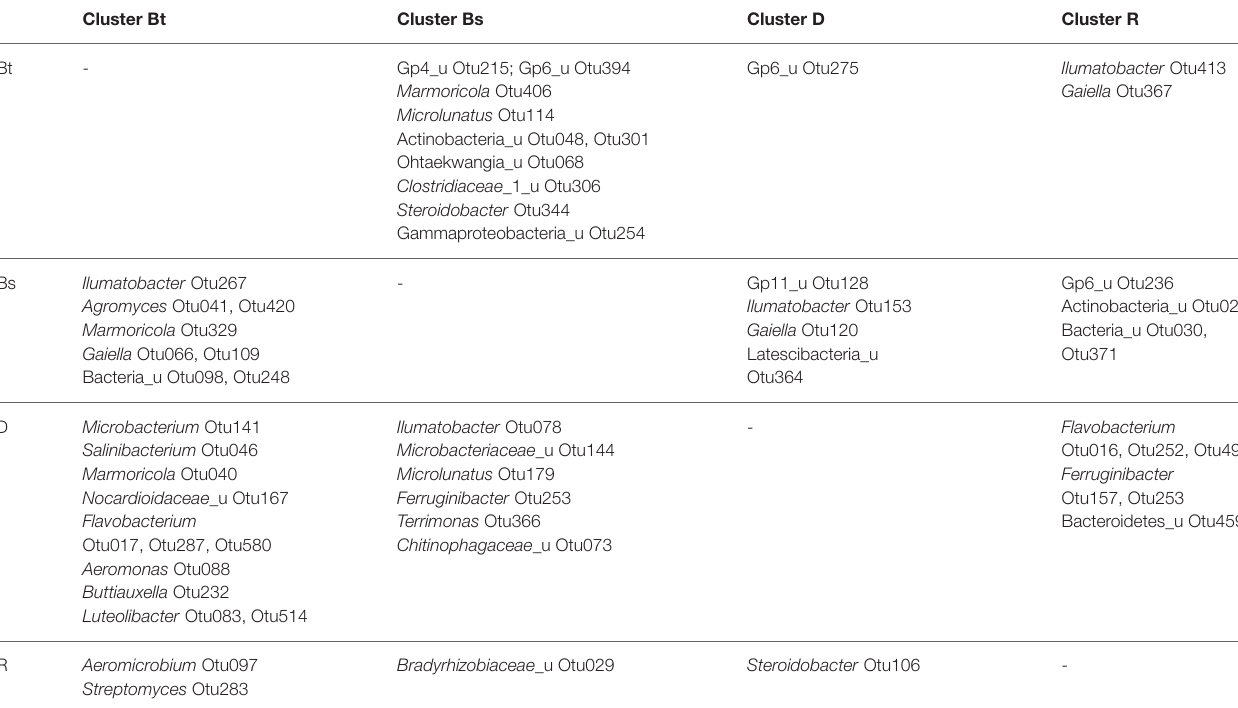
TABLE 1 | Negative correlations between clusters of co-occurring OTUs. Cluster